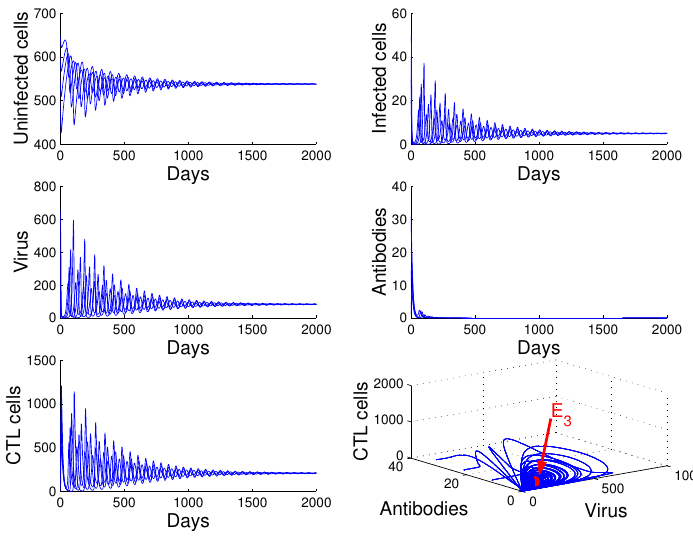
Figure 4. Demonstration of the global stability of the infection equilibrium with only cellular immunity = 3.8301 > 1, and R W = 0.8292 ≤ E 3 for R 0 = 2.2923 > 1, R Z 3 1